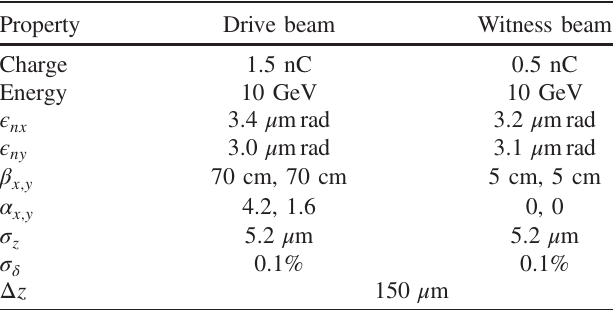
TABLE II. Electron beam parameters used in PIC simulation based on projected parameters for